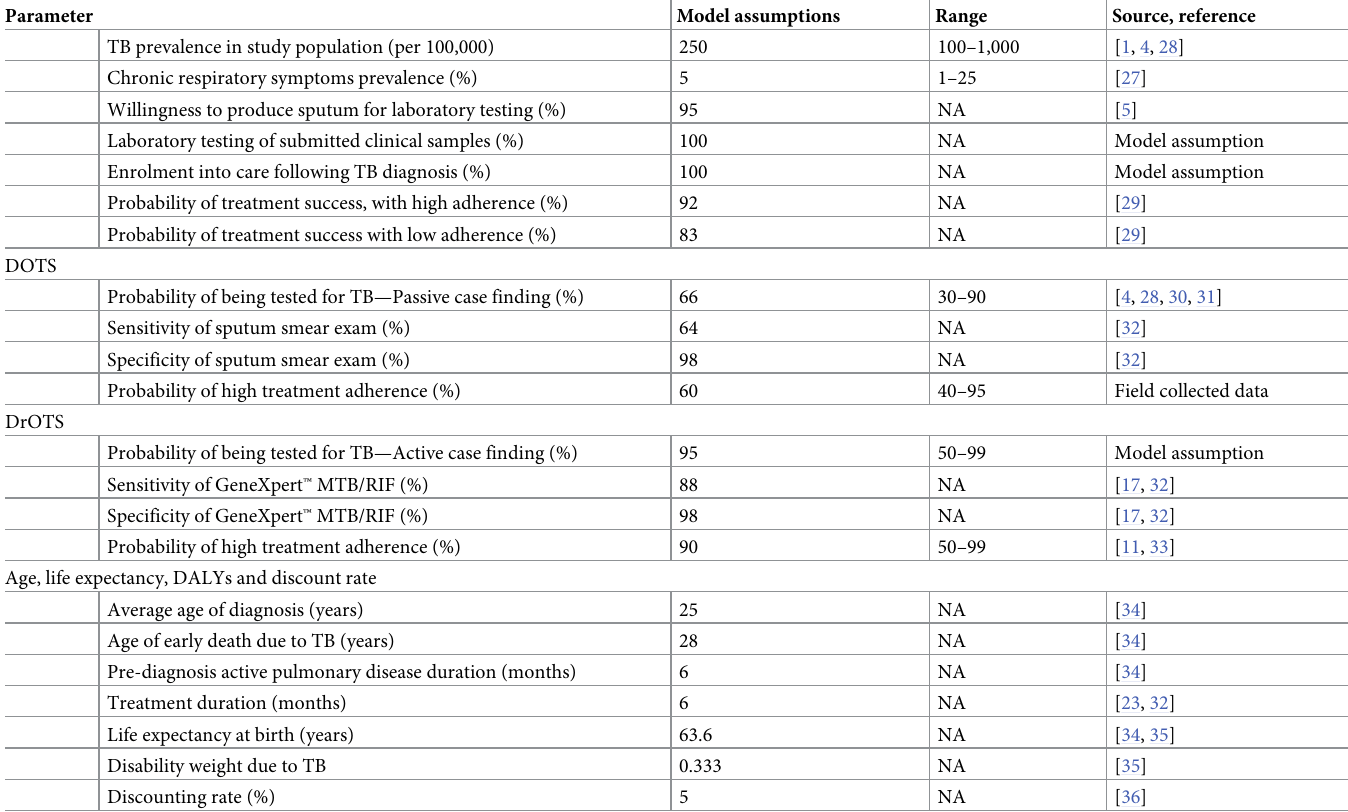
Table 1. Model inputs: Parameters, model assumptions, and sensitivity analyses